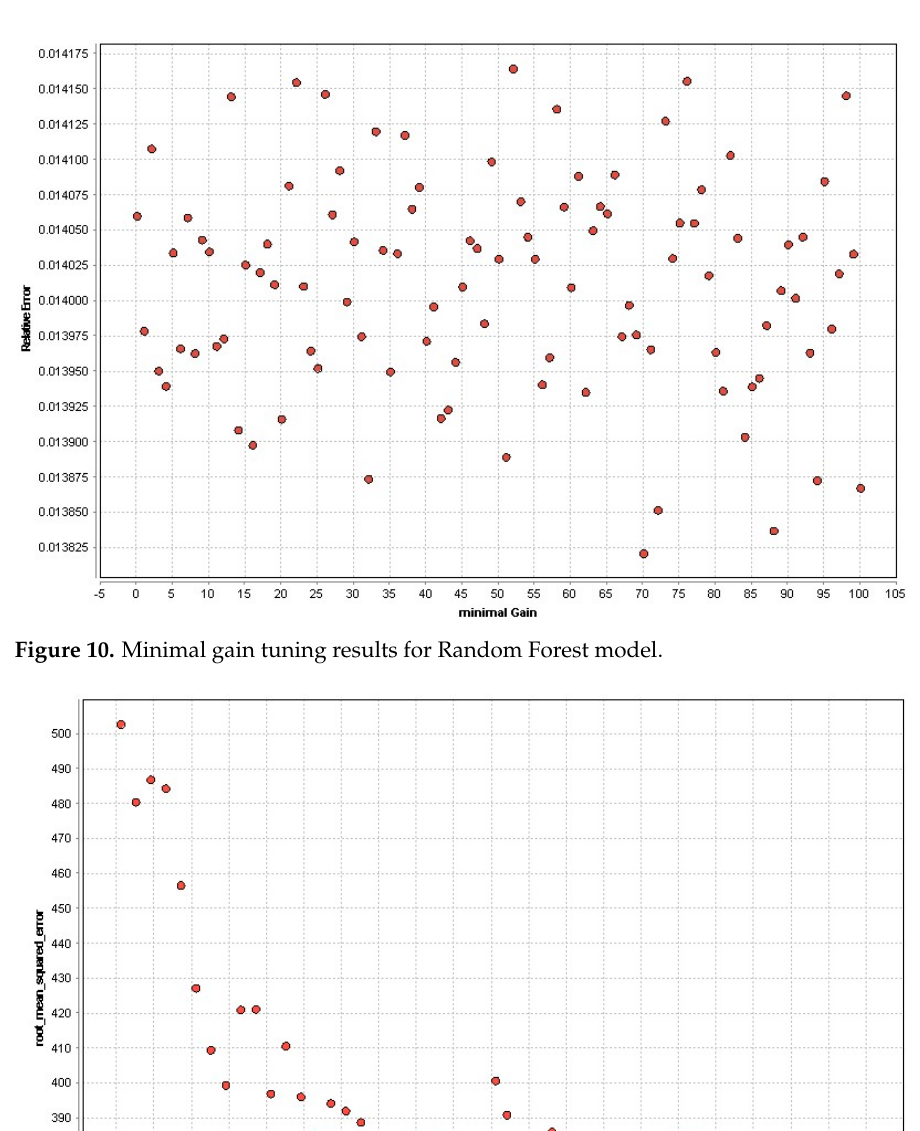
Figure 9. Minimal gain tuning results for Decision Tree model.